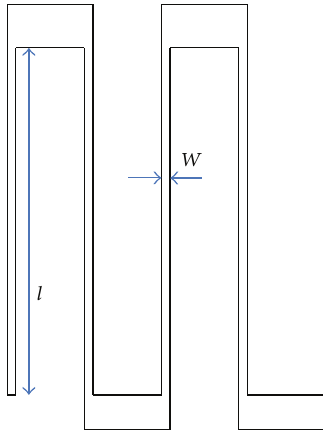
Figure5:Aclose-upoftheserpentinespringusedinthesimulation.